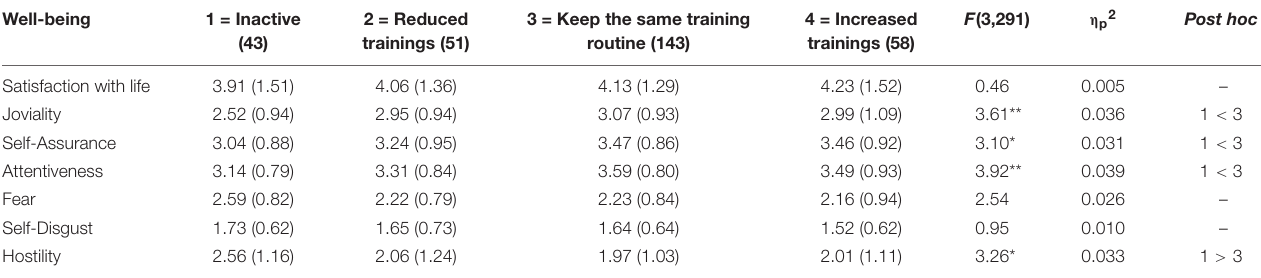
TABLE 5 | Results of one-way ANOVAs: differences in well-being regarding the changes in the training routine during the curfew among recreational and elite athletes ( N = 295). Well-being 1 = Inactive 2 = Reduced (43) trainings